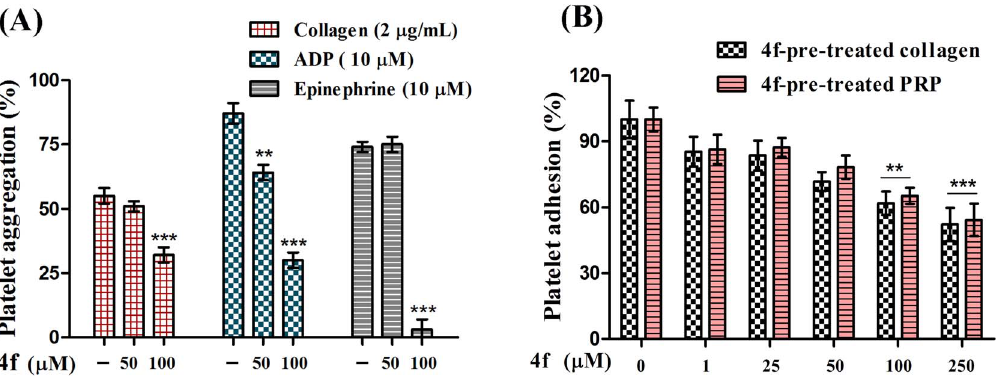
Figure 6. Effect of compound 4f on (A) Platelet aggregation induced by Collagen/ADP/Epinephrine and (B) Platelet adhesion on immobilized collagen type I with compound 4f pre-treated collagen and PRP pre-treated with compound 4f. Values are presented as mean 6 SEM (n=5), expressed as percentage decrease in aggregation and increase in platelet adhesion. ** p , 0.01, *** p , 0.001; significant compared to